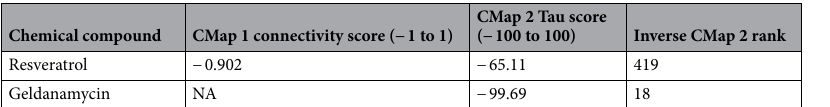
Table 2. Compound rankings from GSEA-analysis using previously reported signature from Braconi et al. (2009). Inverse-ranks are reported for “reversing” the query signature. As with Table 1, CMap 2 ranks are relative to CMap 1 compounds contained in CMap